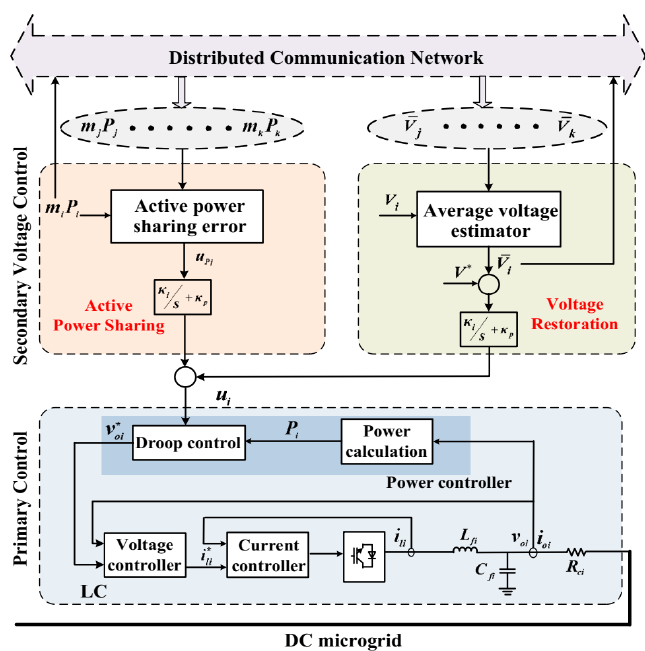
Figure 1. Hierarchical control structure for DC